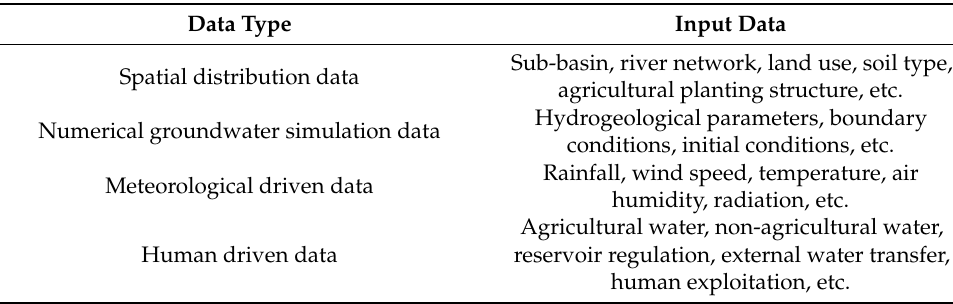
Table 1. Model input parameters and